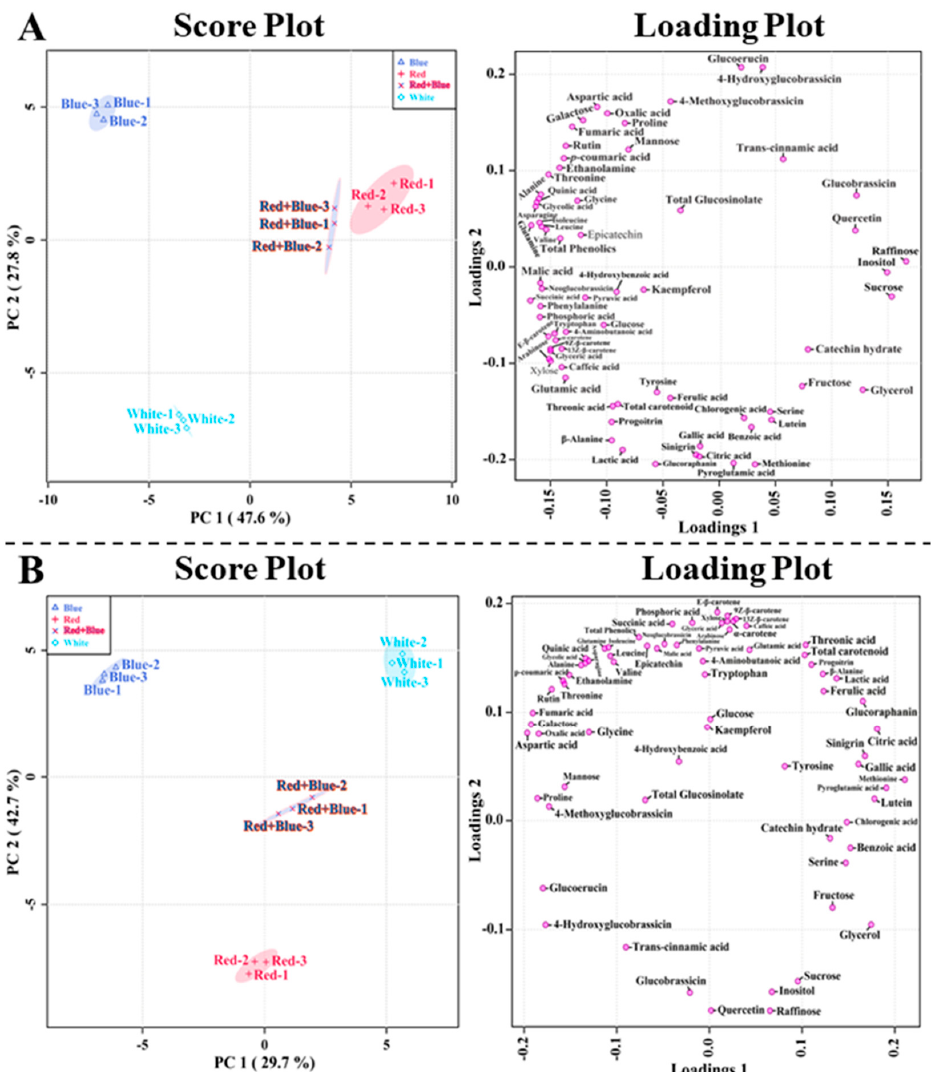
Figure 7. Score and loading plot of the PCA ( A ) and PLS-DA ( B ) models of the metabolites identified in kohlrabi sprouts after exposure to di ff erent LED light conditions.